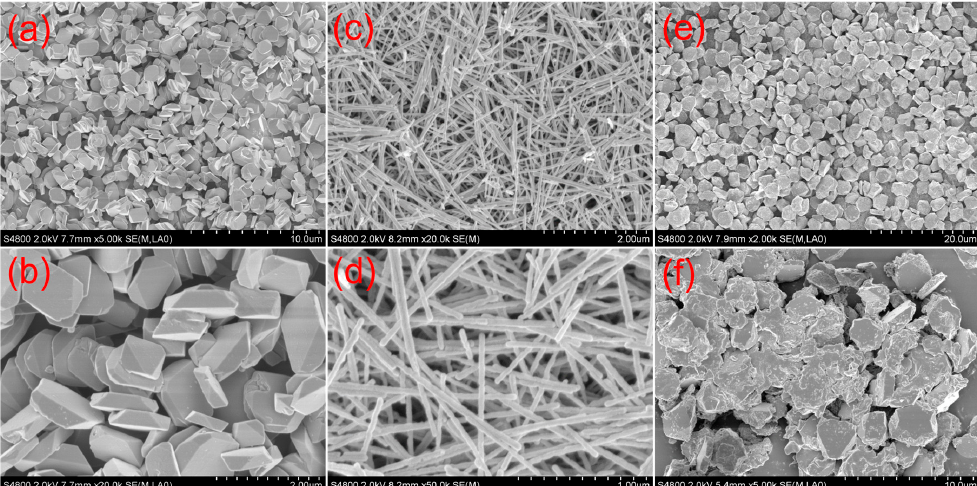
Figure 4. SEM images of α -Fe 2 O 3 prepared with different Zn/Fe molar ratios. ( a , b ) are pure α -Fe 2 O 3 . ( c , d ) are 1% Zn-doped α -Fe 2 O 3 . ( e , f ) are 3% Zn-doped α -Fe 2 O 3 .